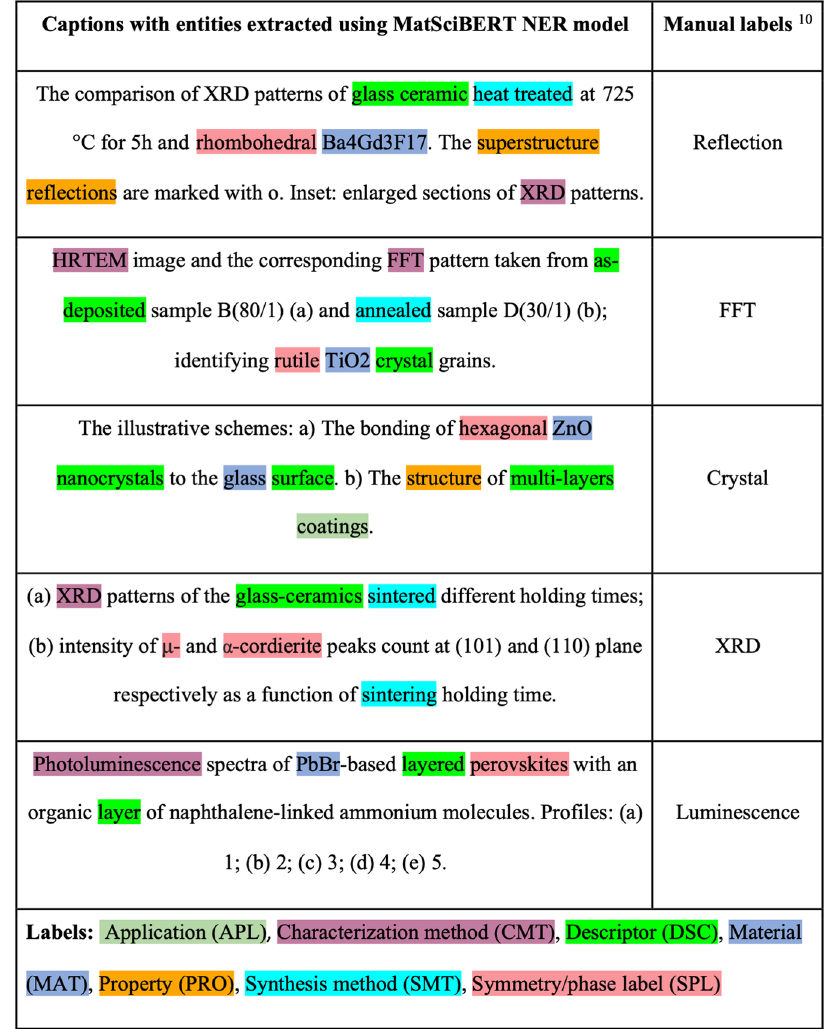
Fig. 4 Comparison of MatSciBERT based NER tagging with manually assigned labels. MatSciBERT-based NER model is able to extract multiple entities as compared to single manual label for each caption.